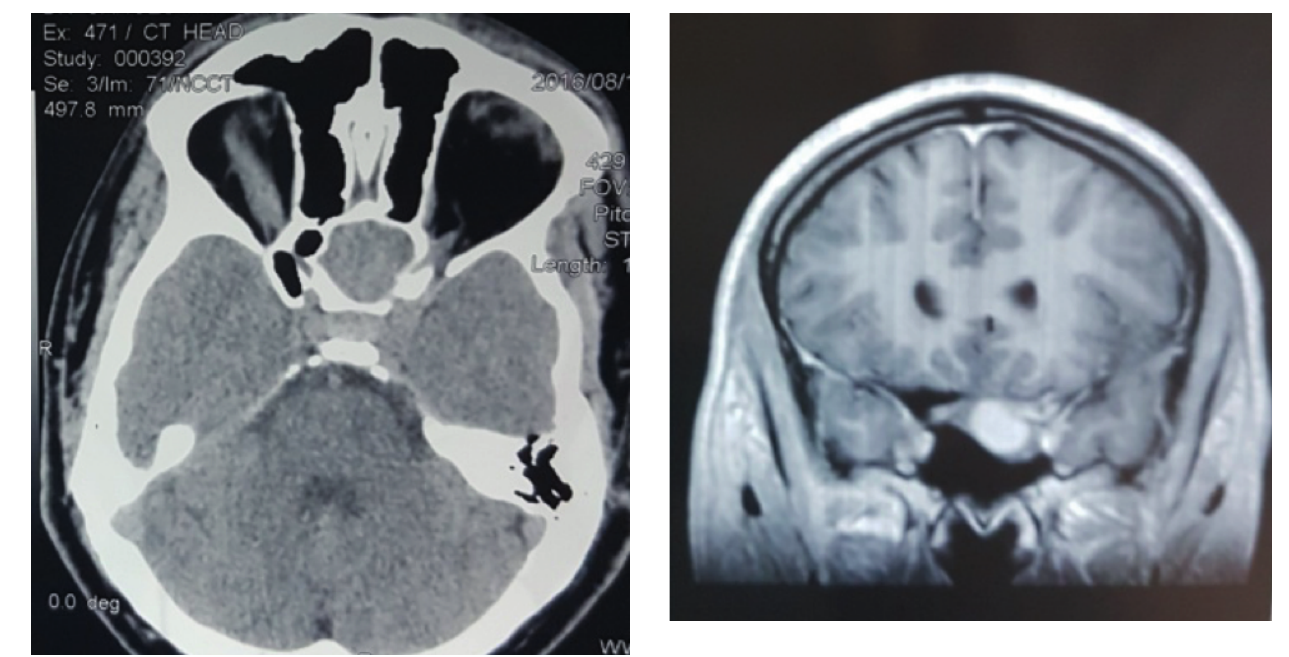
Figure 1. CT scan showing soft tissue density in sphenoid sinus.